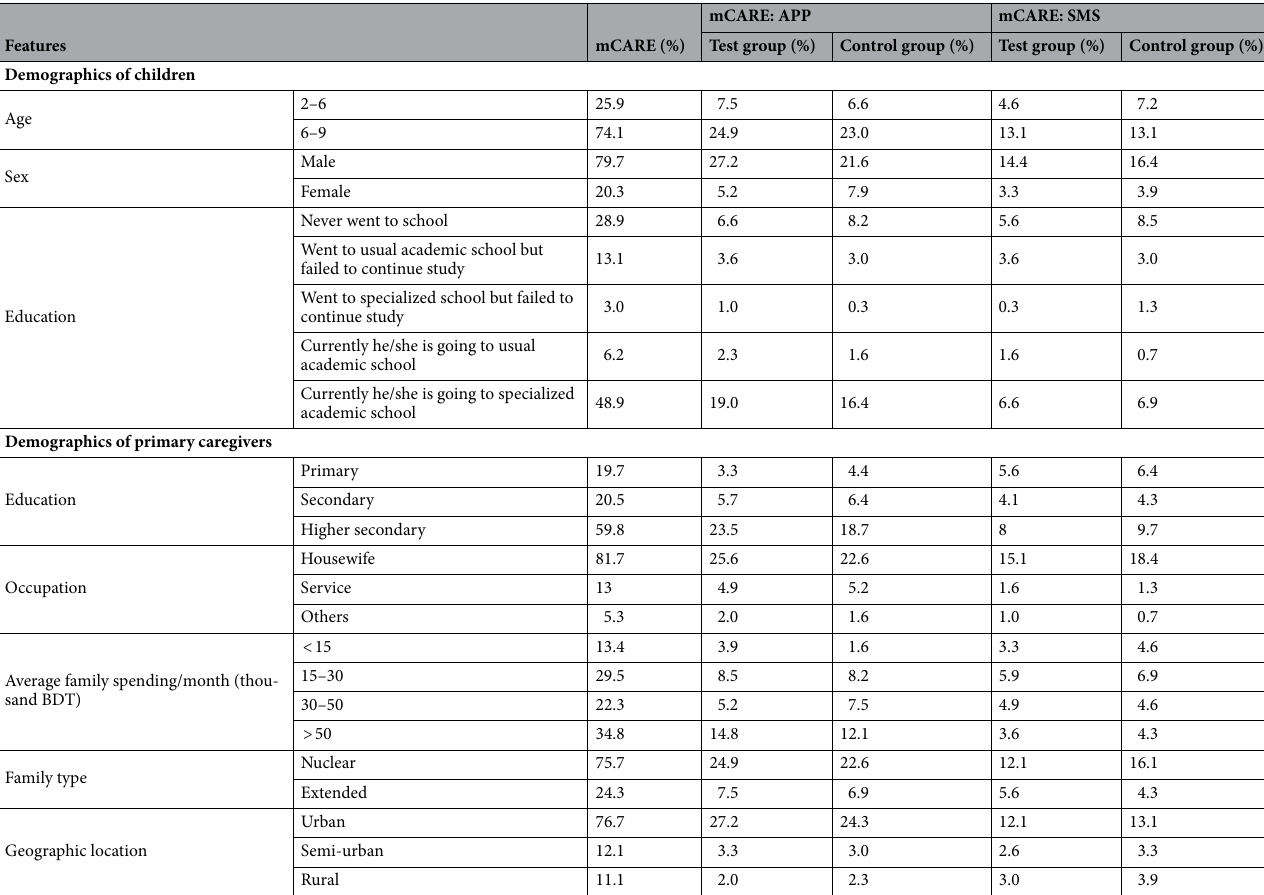
Table 2. Participant’s sociodemographic